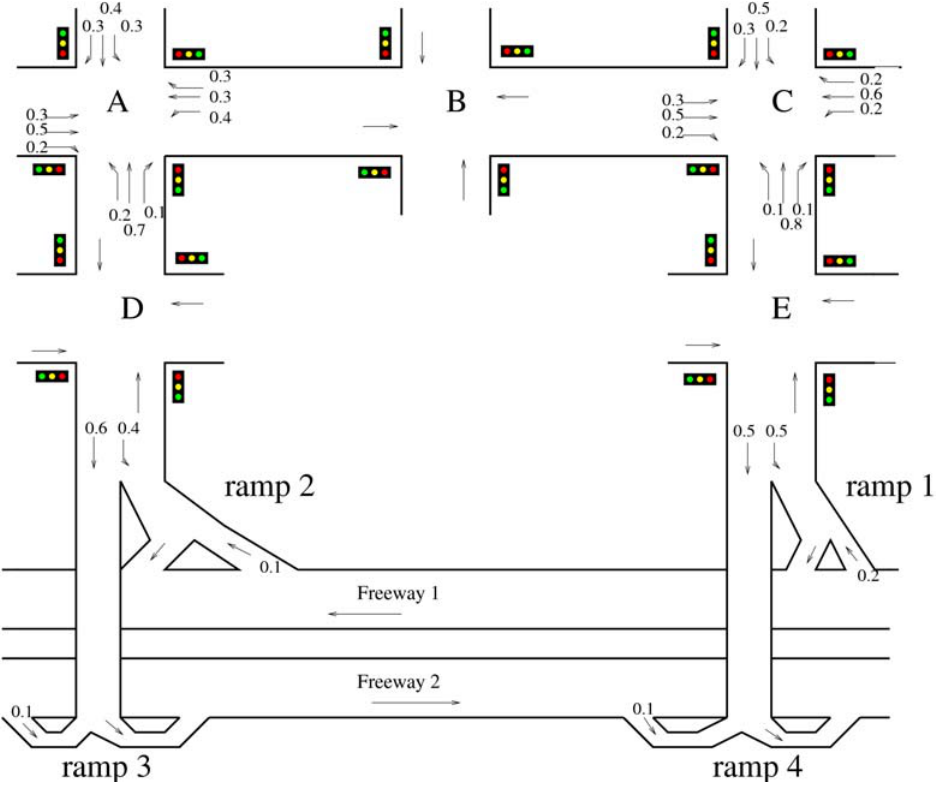
Figure 8. Network used in the case